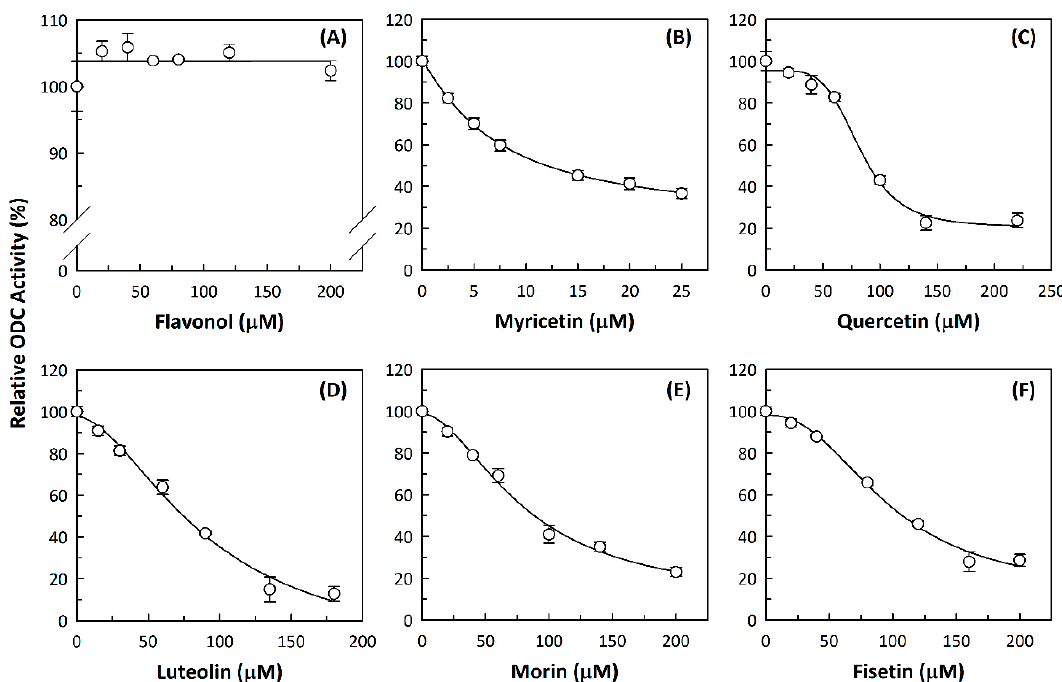
Figure 2. Dose-dependent inhibition of flavonol derivatives toward the ODC enzyme. ( A ) Flavonol; ( B ) myricetin; ( C ) quercetin; ( D ) luteolin; ( E ) morin; ( F ) fisetin. Enzyme activity of ODC were measured with a series of concentrations of the respective flavonol derivatives ( n = 3).